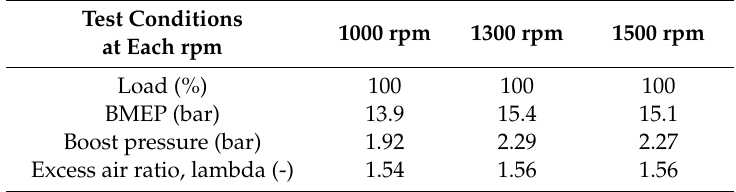
Table 2. Engine test conditions o ff ered by OEM (Original Equipment